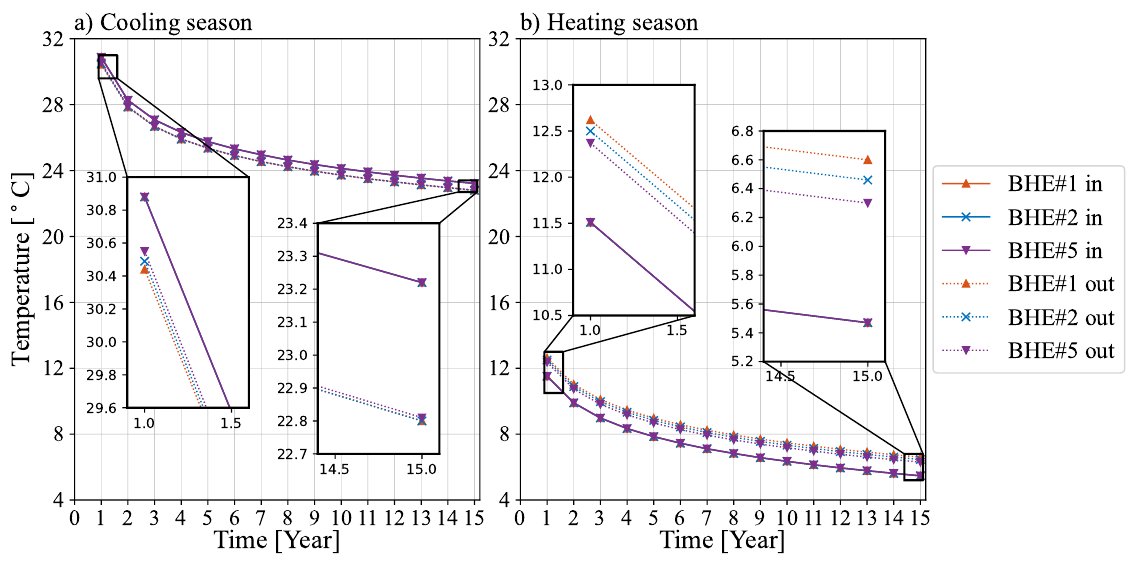
Figure 9. Evolution of inflow and outflow temperature of the selected MSBHEs in the end of ( a ) cooling season and ( b ) heating season under scenario #6 over 15